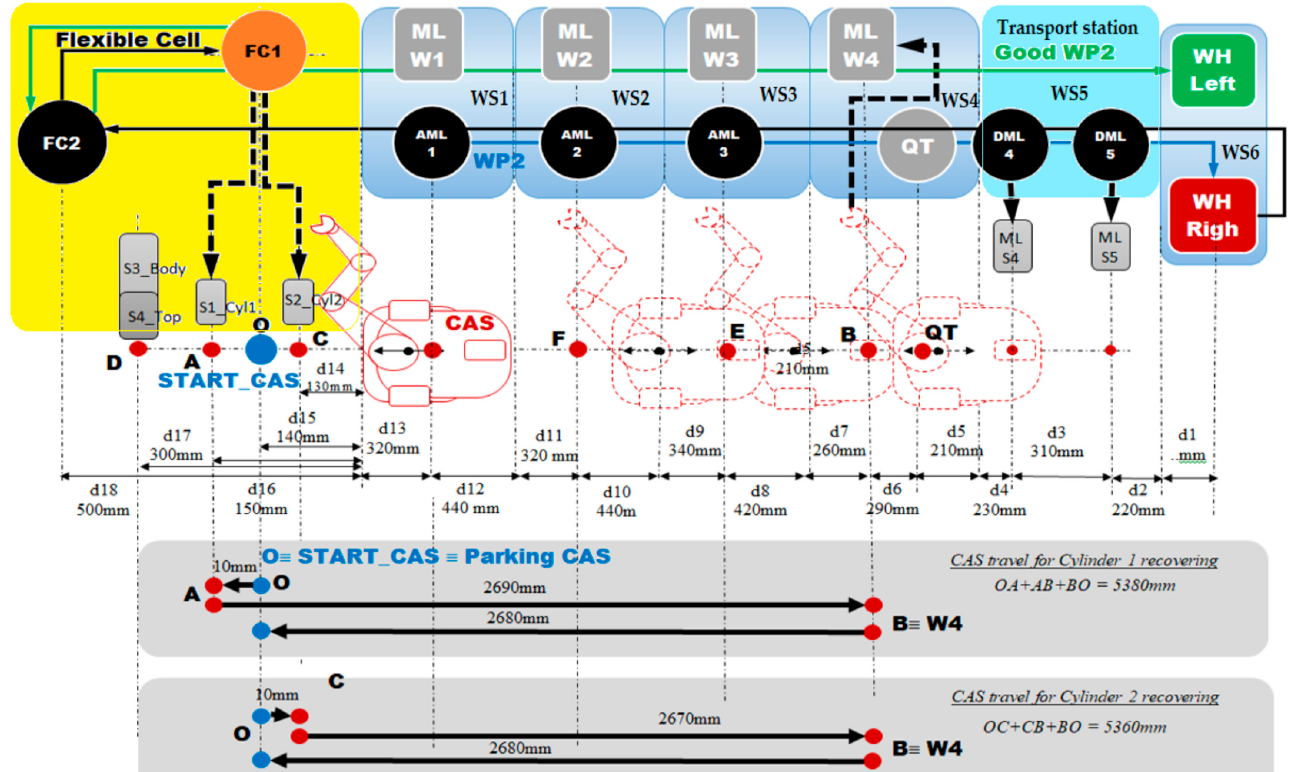
Figure 5. A/D/RML and distances traveled by CAS for cylinder recovery corresponding to the repair function.